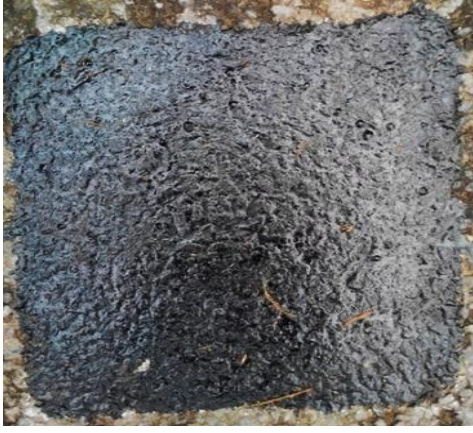
Figure 3. Thin film on the pavement.